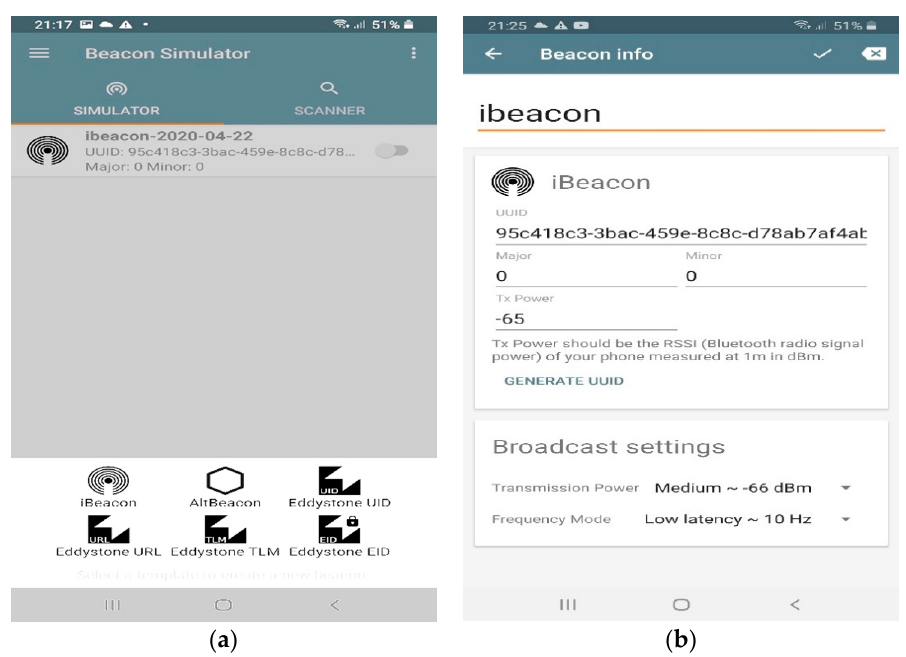
Figure 6. Beacon Simulator application user interface. ( a ) Different beacon platforms; ( b ) iBeacon main configuration used in the experiment [41].